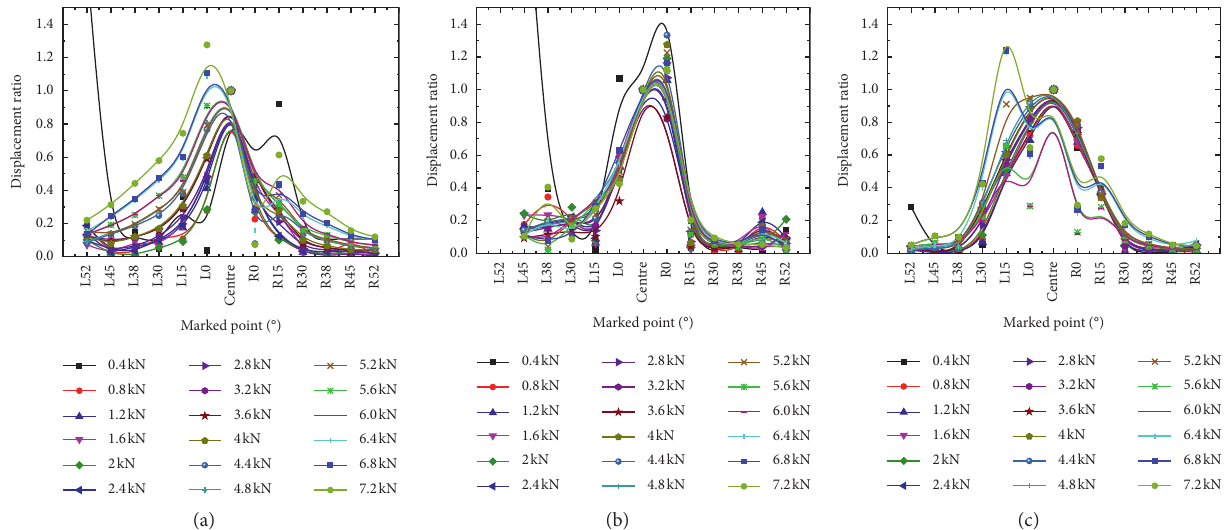
Figure 15: Distribution curve of soil displacement according to diffusion angle under different loads at 0 ° . (a) The 0 b row. (b) The 0.75 b row. (c) The 1.50 b row.